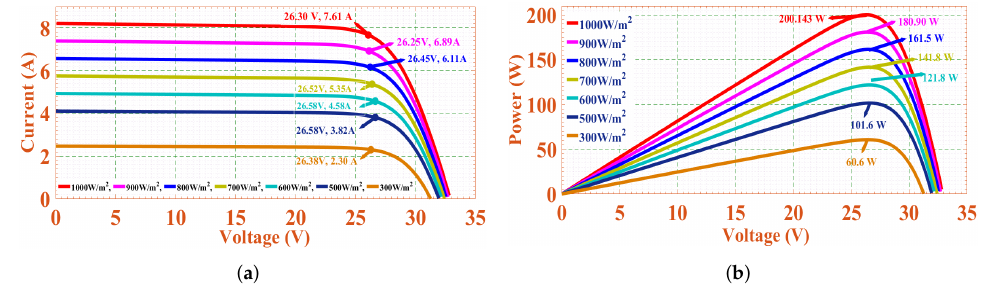
Figure 2. KC200GT PV module output characteristics. ( a ) I–V , and ( b ) P–V